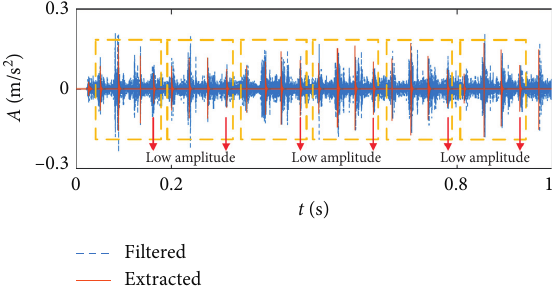
Figure 18: Experimental misfire fault signal processed by the proposed